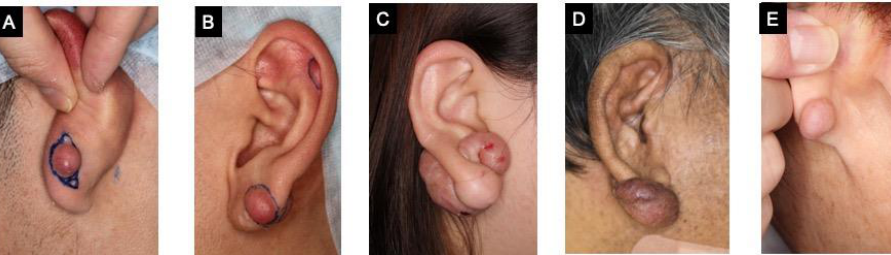
Figure 1. Patients with keloids in the earlobe. ( A – E ) were shown in order of increasing age. The patients were diagnosed with ‘keloids’ by hematoxylin and eosin staining (Fig- ure 2I). More specific histological examination with toluidine blue staining revealed activation of the mast cells in the keloids (Figure